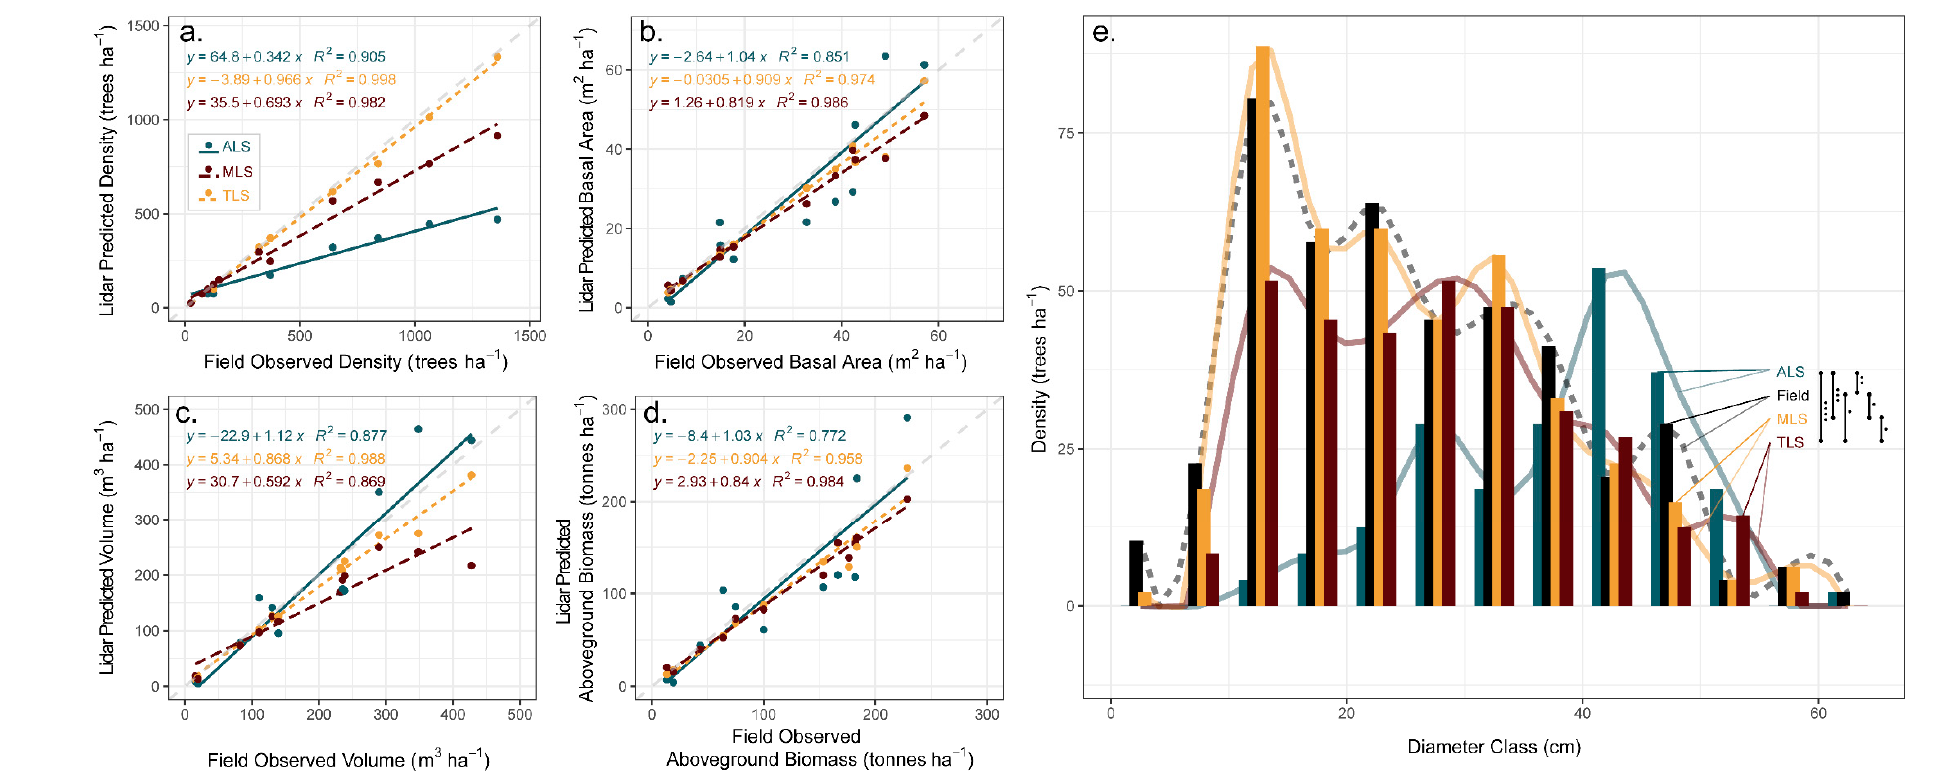
Figure 6. Plot-level scatter plots and simple linear regression fit information for ( a ) tree density, ( b ) basal area, ( c ) total stem wood volume, ( d ) total aboveground oven-dry biomass obtained from airborne (ALS), mobile (MLS) and terrestrial laser scanning (TLS) platforms, as well as their corresponding and field-observed ( e ) diameter distribution, for ponderosa pine stand conditions in northern Arizona, USA. Tests of differences (Kolmogorov-Smirnov) in tree size class distributions measured in the field and derived from the three lidar platforms depicted using overlapping lines and dots.